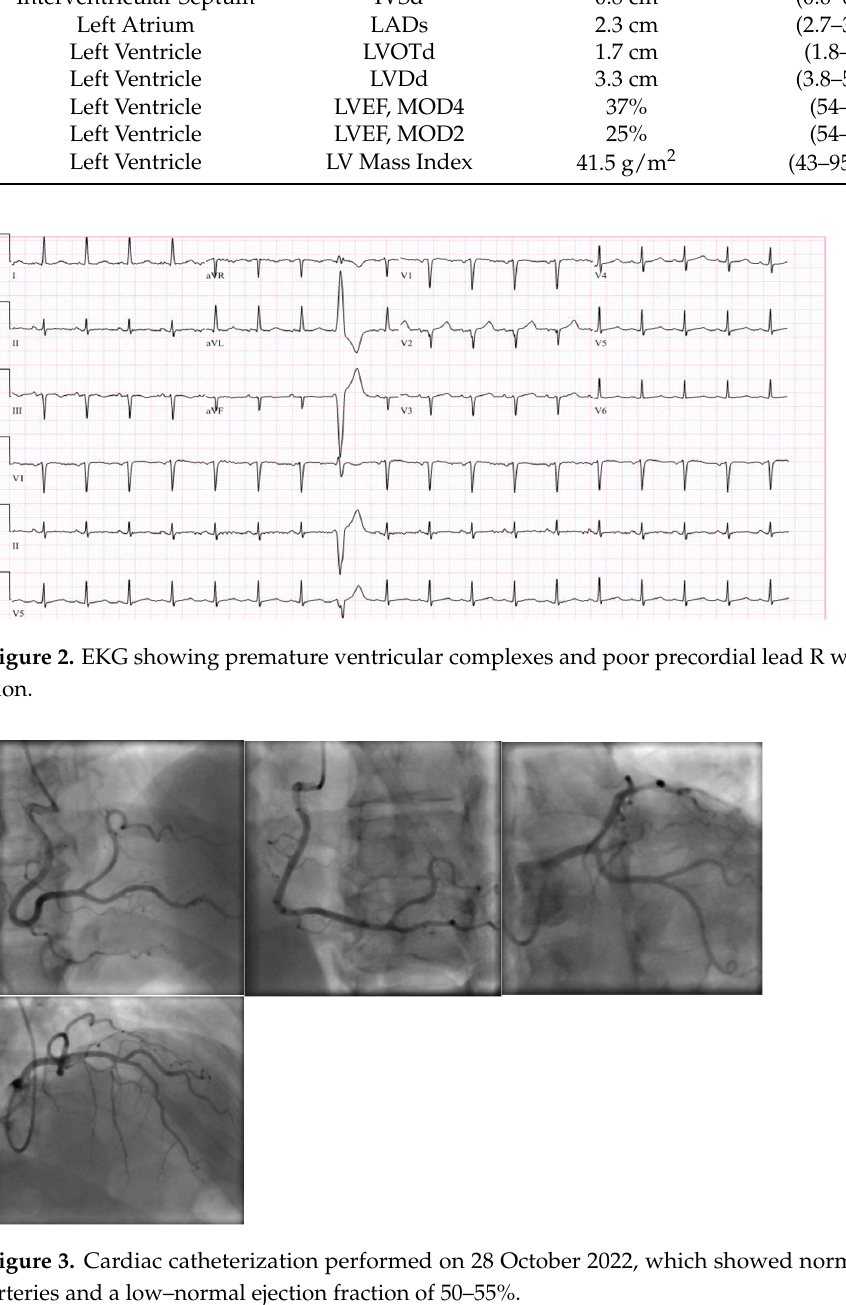
Table 2. Results of echocardiogram from 26 October 2022.